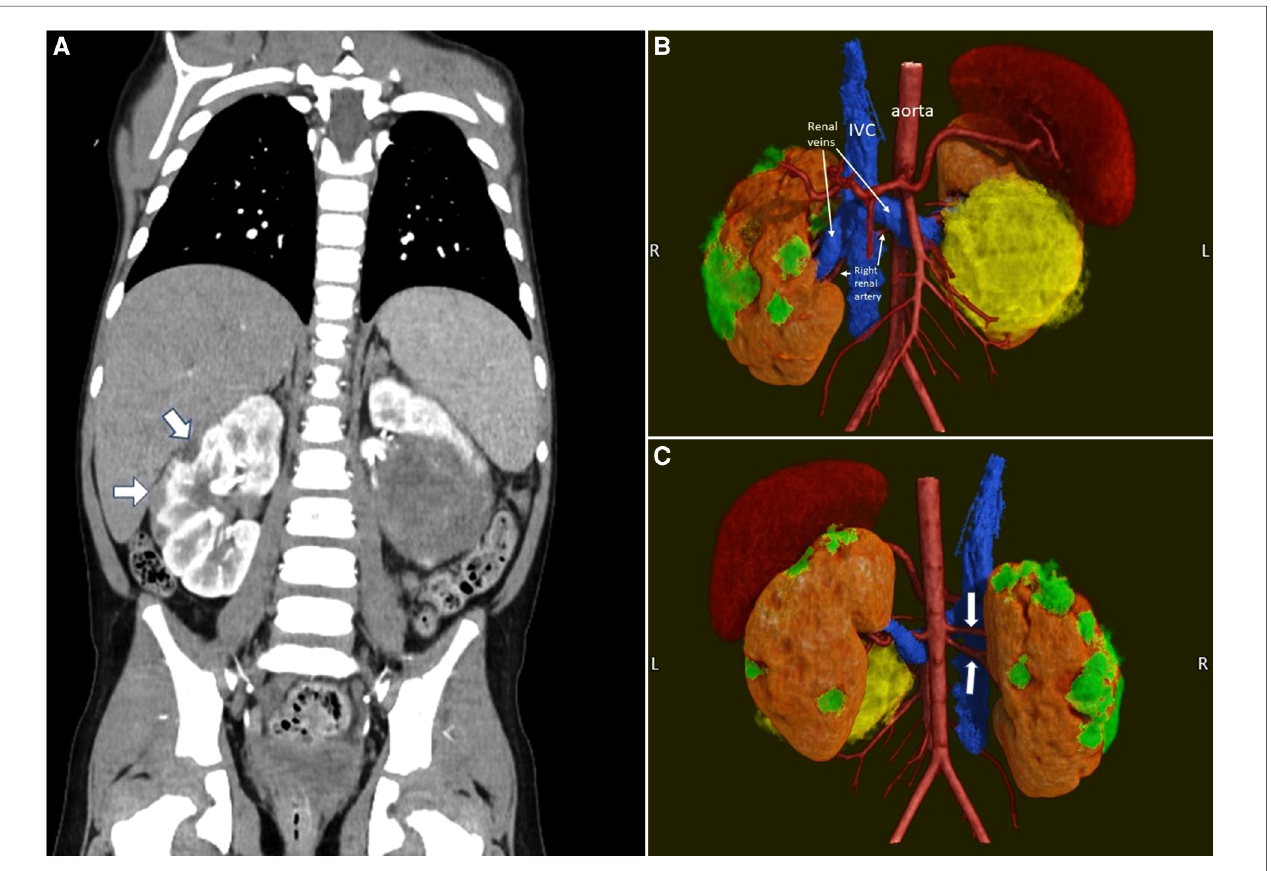
FIGURE 7 Pre-operative imaging of a case of synchronous bilateral Wilms tumor. ( A ) Pre-operative CT scan. Note the multiple peripheral lesions on the right kidney. ( B ) 3D rendering (anterior view) of the kidneys, their tumors and the vasculature. The smaller right kidney tumors are in green. The large left kidney tumor is in yellow. ( C ) 3D rendering (posterior view). Note the two right renal arteries (white arrows).